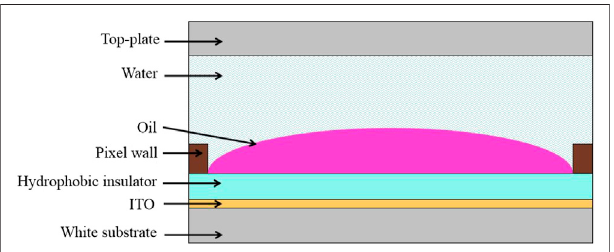
FIGURE 1 | Pixel structure of EWDs. The optical stack consists of glass substrate, indium tin oxide (ITO), hydrophobic insulator layer, pixel wall, colored oil, and